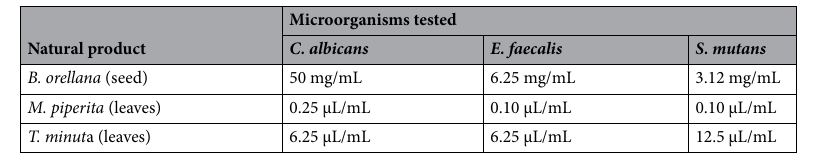
Table 3. In vitro antimicrobial activity of the essential oils and vegetable extracts by determining the minimum inhibitory concentration (MIC).